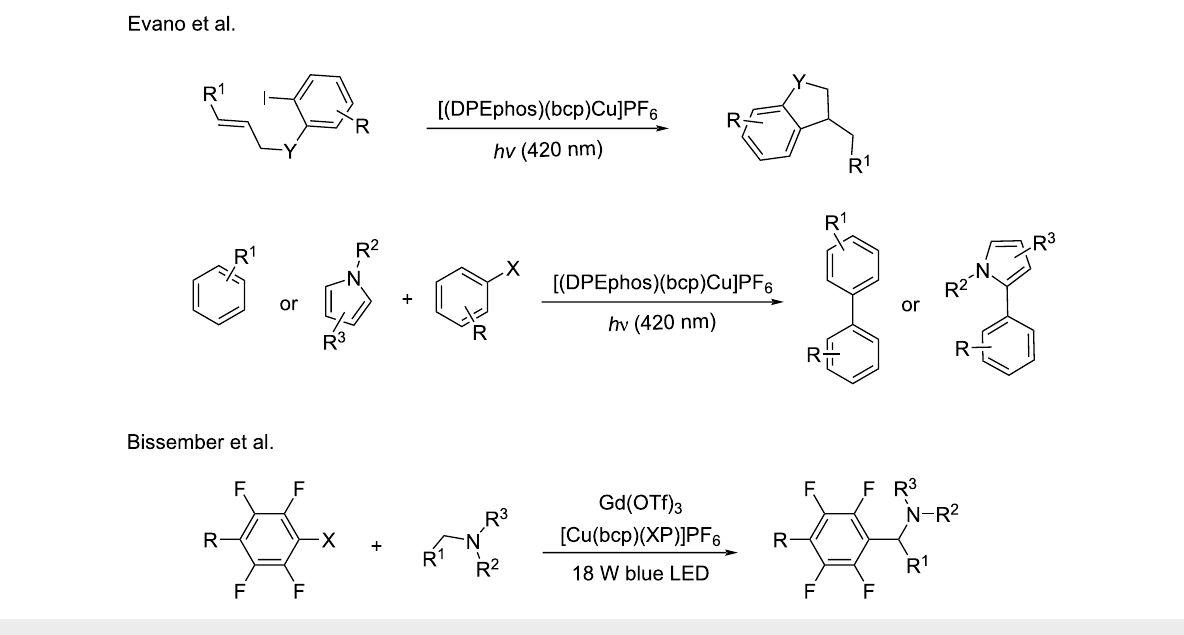
Scheme 24: C–C cross-coupling of aryl halides and heteroarenes.